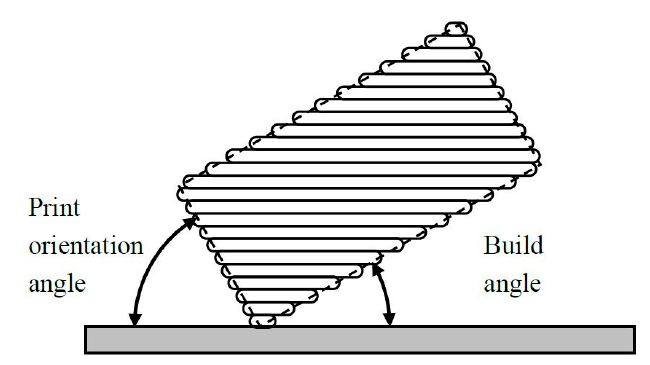
Figure 6. Schematic of a printed part with the print orientation angle and the build angle.